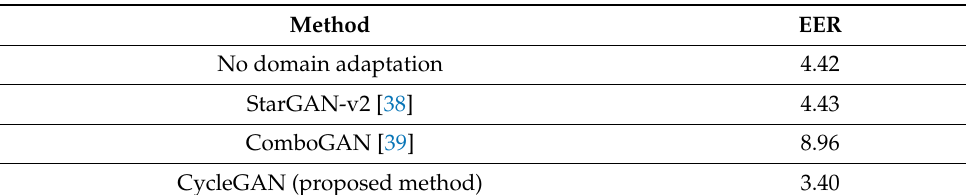
Table 10. Comparisons of EERs of the proposed method and other domain adaptation methods in case of training with HKPolyU-DB and testing with SDUMLA-HMT-DB (unit: